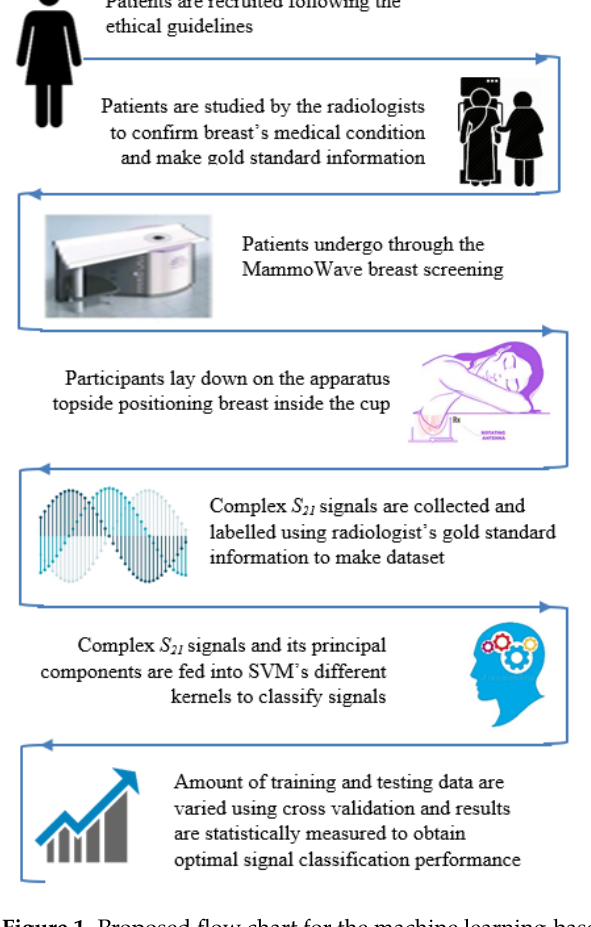
Figure 1. Proposed flow chart for the machine learning-based breast lesion